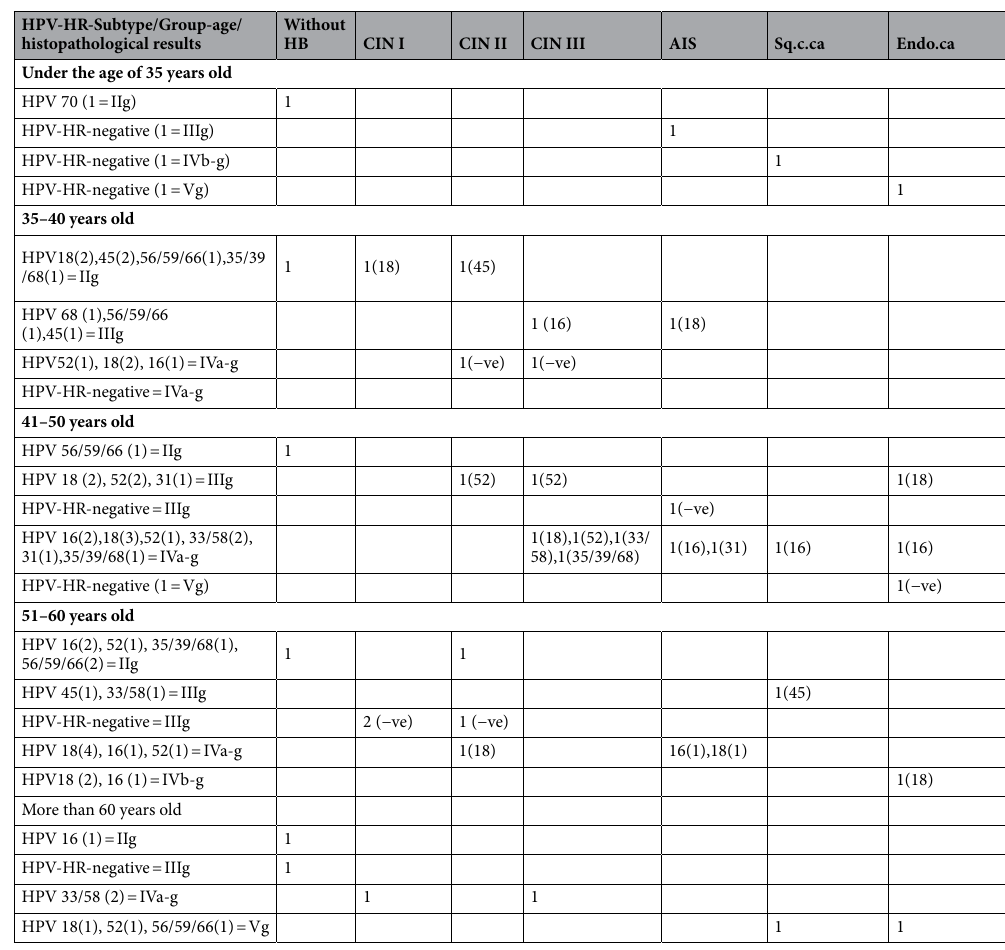
Table 4. HPV high-risk subtype in relation to cytological group and histopathological diagnosis. HB Histopathological biopsy; AIS Adenocarcinoma in situ; Sq.c.ca Squamous cell carcinoma; End. Ca. Endometrial